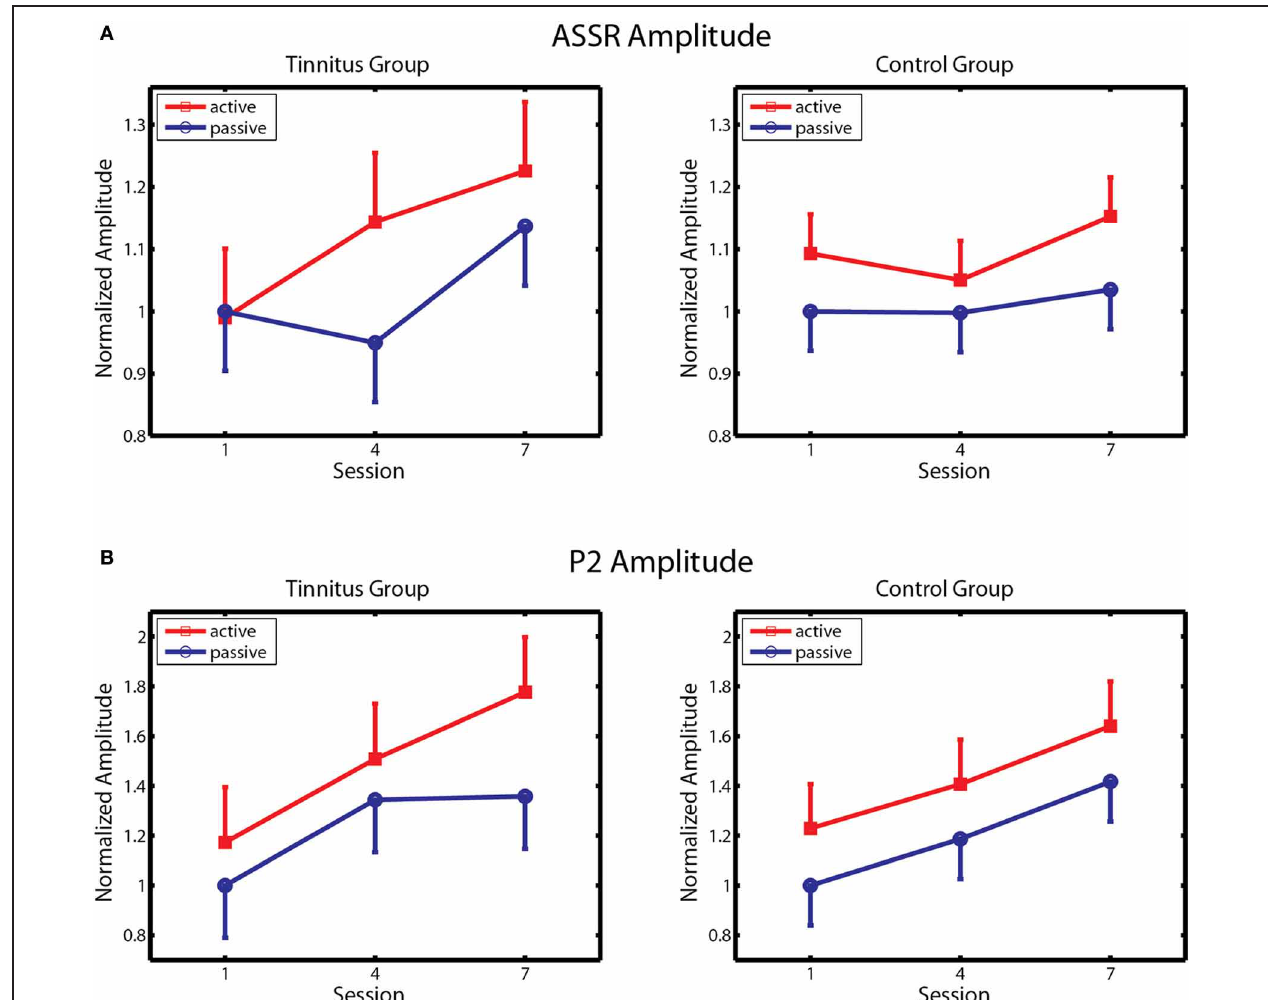
FIGURE 5 | ASSR amplitude and P2 amplitude. (A) Changes in ASSR amplitude over training in the Tinnitus (left panel) and Control (right panel) groups, on active and passive blocks. (B) Changes in P2 amplitude are